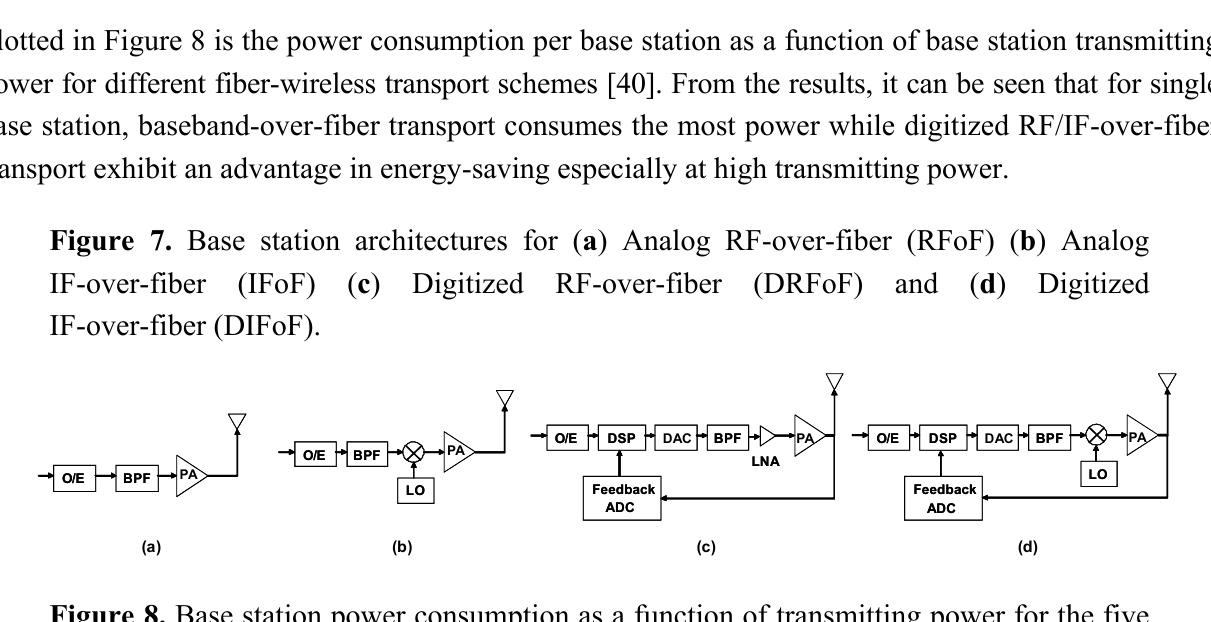
Figure 8. Base station power consumption as a function of transmitting power for the five different transport schemes